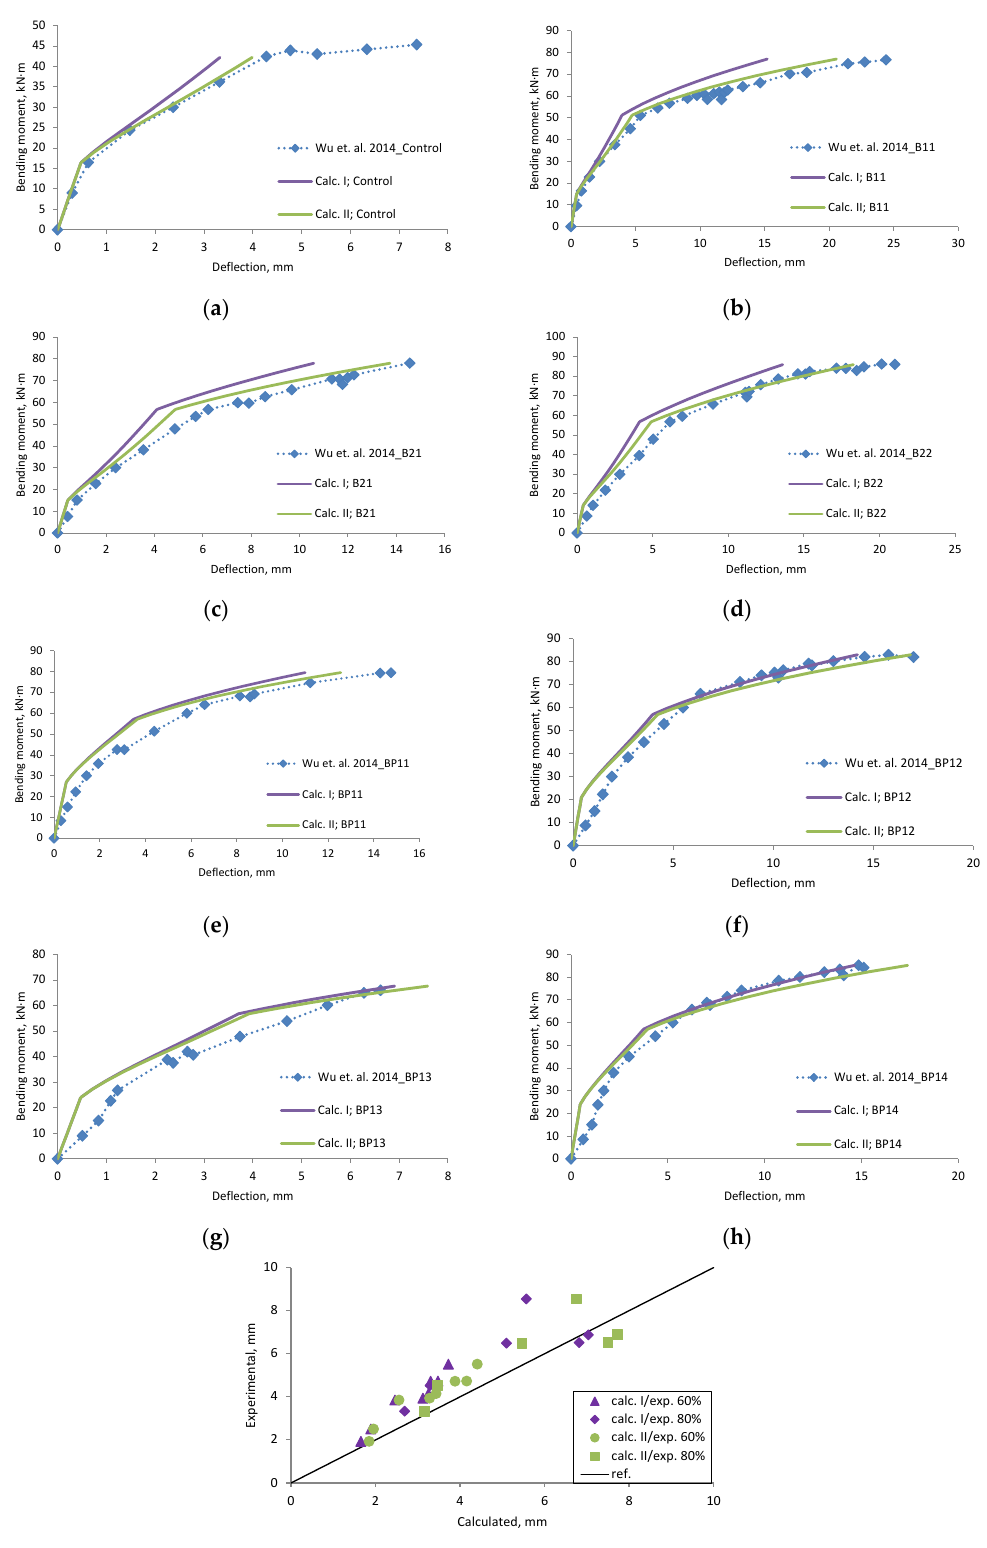
Figure A21. Wu et al., 2014 [43] research beams deflection compared with calculated, ( a ) beam Control; ( b ) beam B11; ( c ) beam B21; ( d ) beam B22; ( e ) beam BP11; ( f ) bam BP12; ( g ) beam BP13; ( h ) beam BP14; ( i ) scatter of the results at 60% and 80% of the ultimate